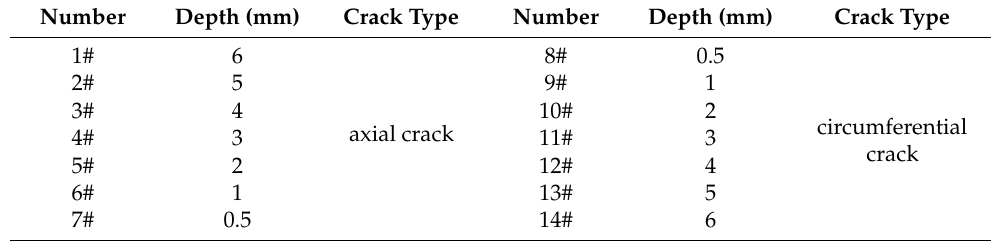
Table 3. Dimensional parameters of